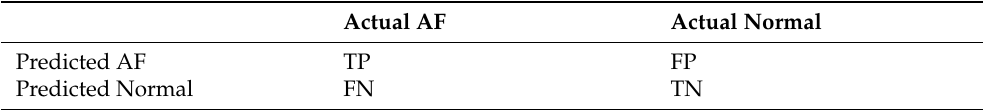
Table 2. Confusion matrix TP, TN, FP,